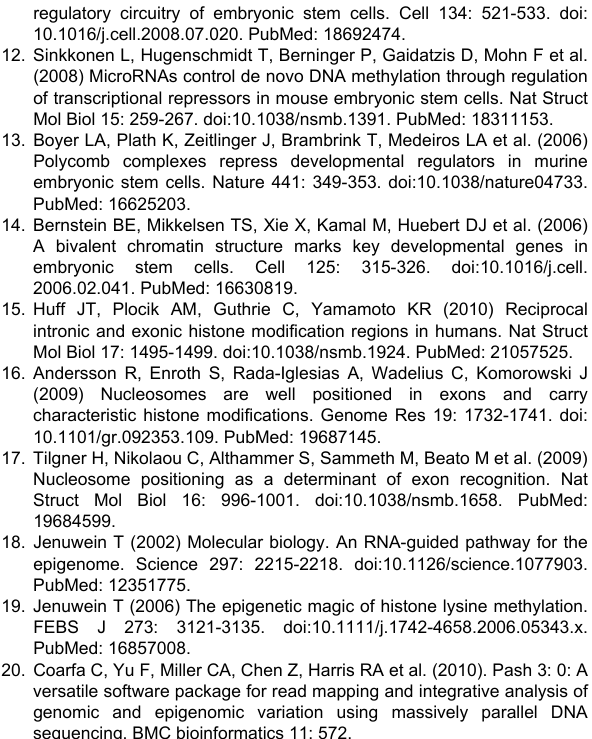
Table S3. Genomic Loci of H3K9me2 in ES and Dicer-/- ES